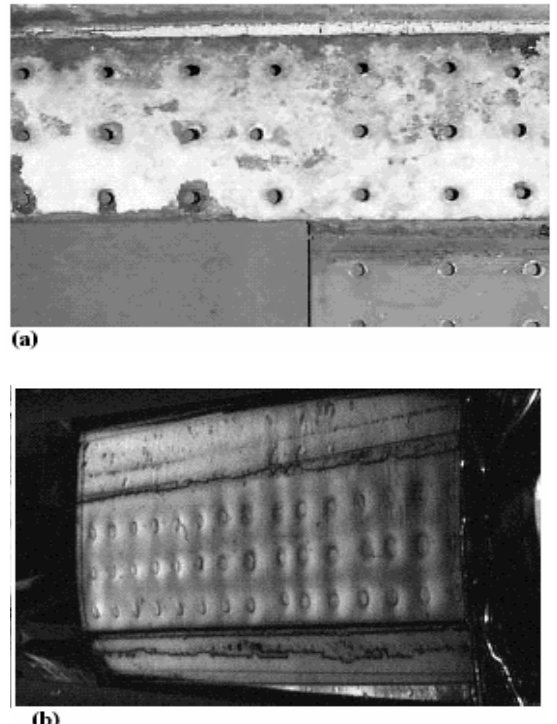
Fig 1. Illustration of a corroded longitudinal fuselage splice from a retired 727: (a) white corrosion product on faying